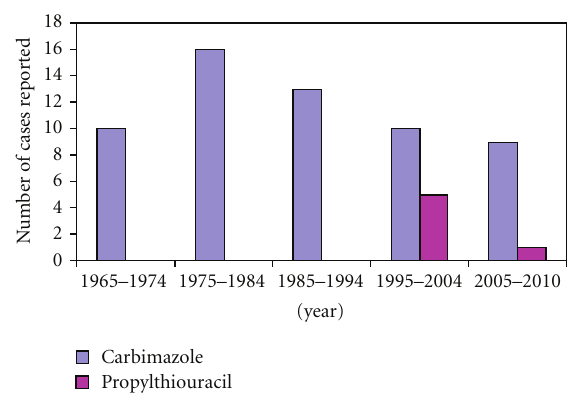
Figure 1: Bar graph showing number of cases with congenital malformations reported following exposure to carbimazole or propylthiouracil by decade from 1965 until